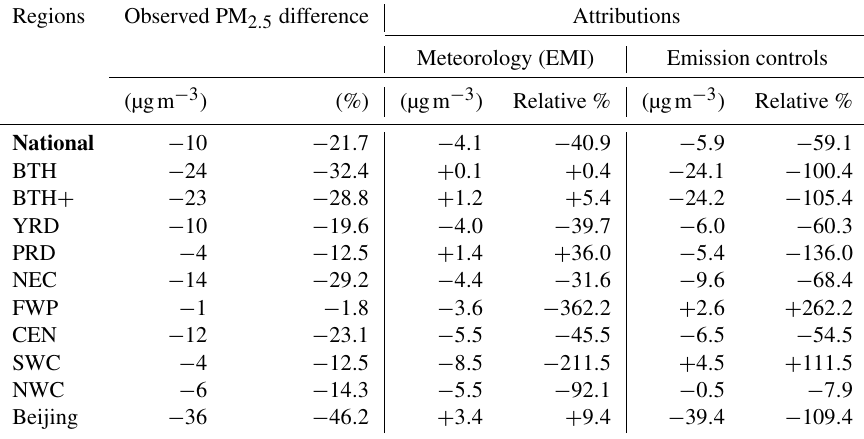
Table 3. Observed PM 2 . 5 difference between 2019 and 2015 as well as its attributions to meteorology and control measures for all of China, Beijing and nine